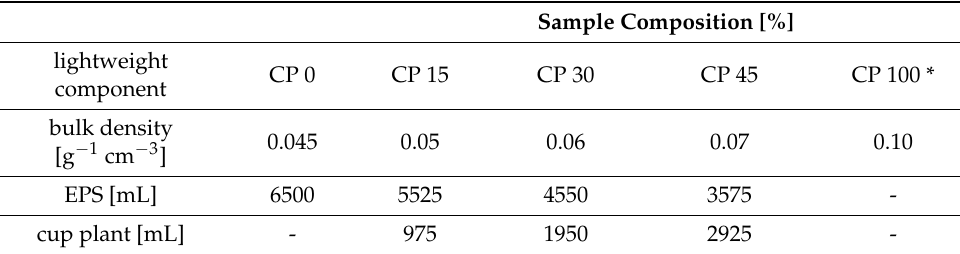
Table 1. Volumetric compositions and bulk densities of the lightweight aggregate mixtures containing cup plant ( CP ) and expanded polystyrene